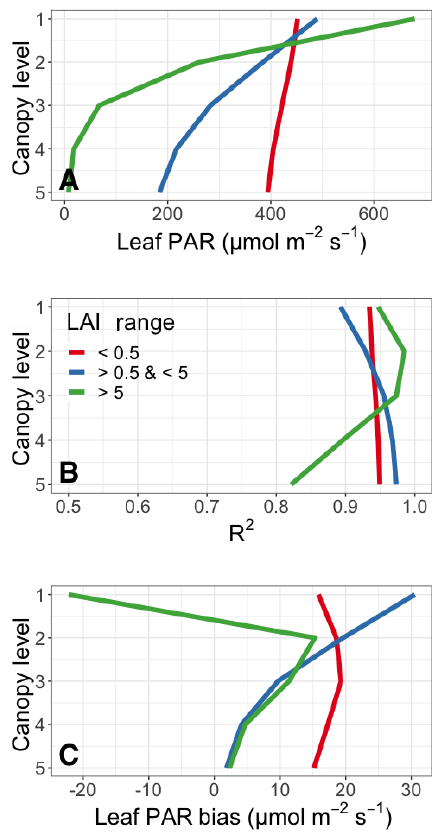
Figure 6. Surrogate model performance for the annual aver- age vertical canopy PAR profile in 2012 as a function of LAI. Panel (a) shows the vertical average surrogate model leaf-level PAR (µmolm − 2 s − 1 ) for low-LAI (red), midrange LAI (blue), and high- LAI canopies. Panel (b) shows the surrogate model R 2 against the full model. Panel (c) shows the leaf-level PAR bias (µmolm − 2 s − 1 ) of the surrogate model compared to the full model. Level 1 is the top of the